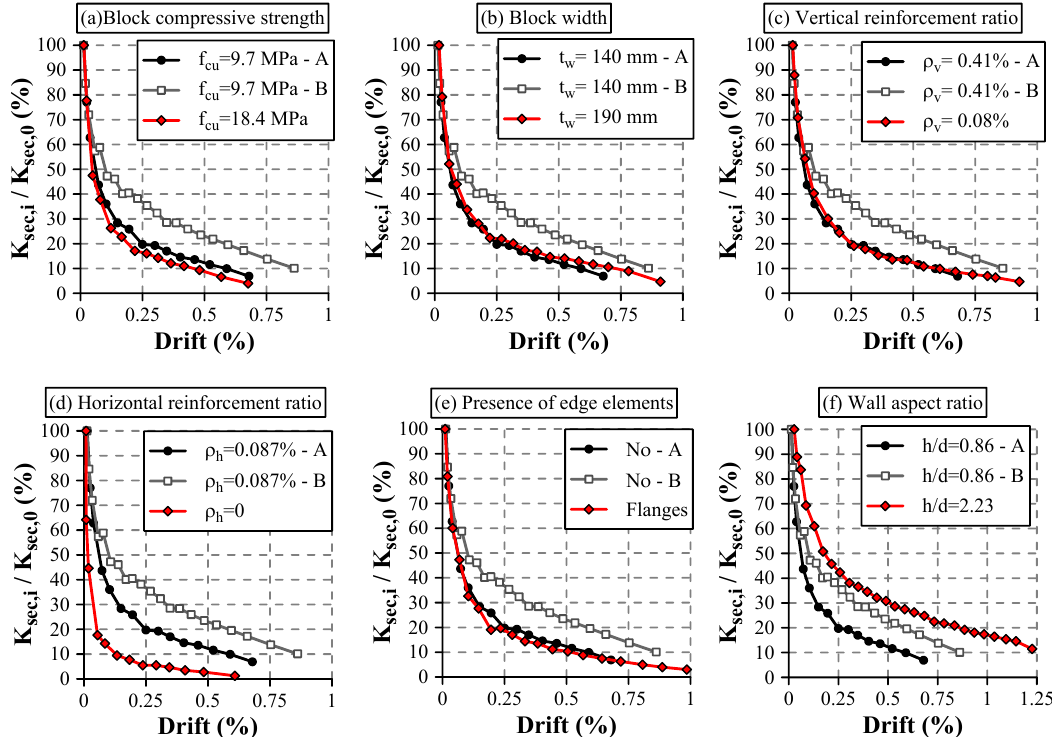
Figure 12. Influence of design parameters on the lateral stiffness degradation: ( a ) block compressive strength, ( b ) block width, ( c ) vertical reinforcement ratio, ( d ) horizontal reinforcement ratio, ( e ) presence of edge elements, and ( f ) wall aspect